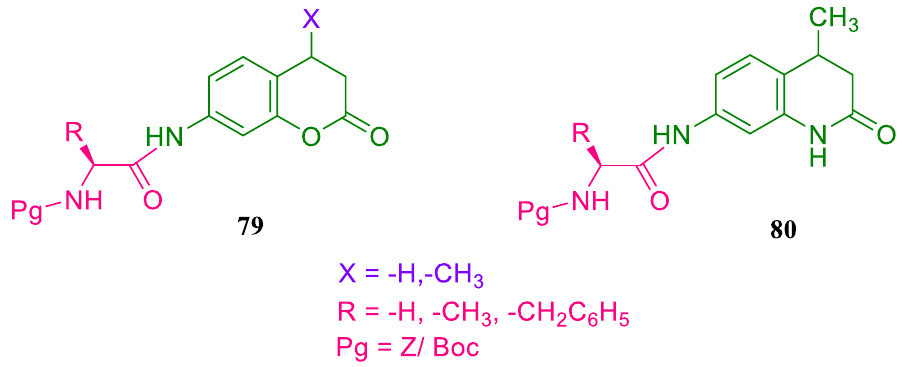
Figure 65. Coumarin/quinolinone conjugated to N-protected amino acids.